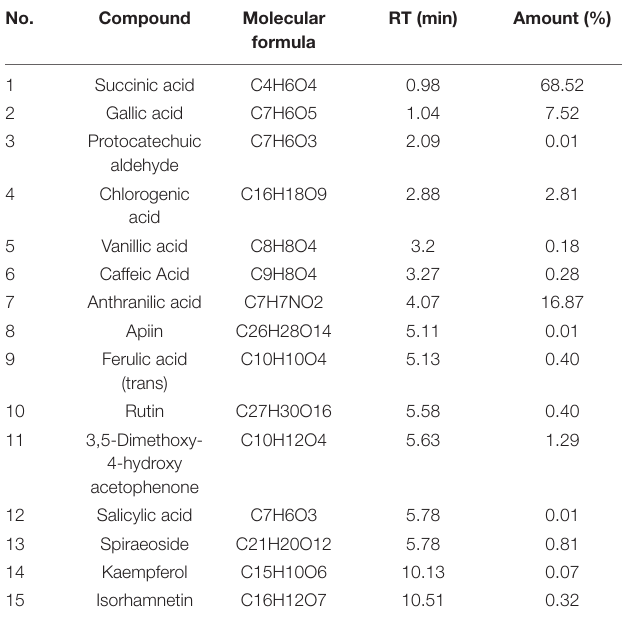
TABLE 1 | Liquid chromatography-mass spectrometer (LC-MS) analysis of Withania somnifera root (WSR) water extract.